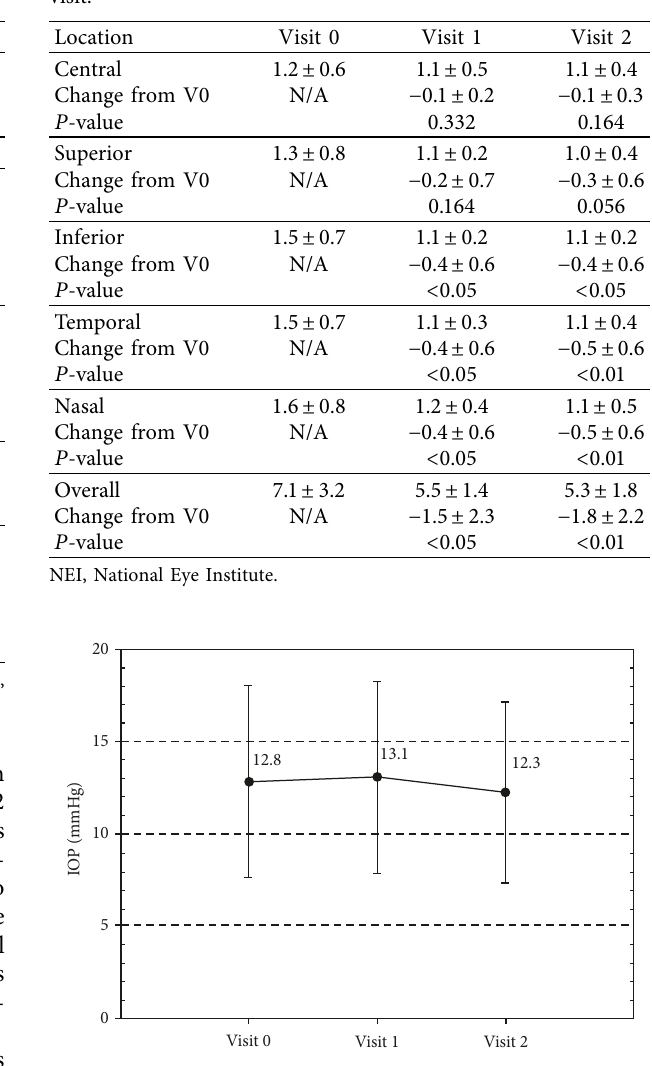
Figure 1: Mean intraocular pressure at each